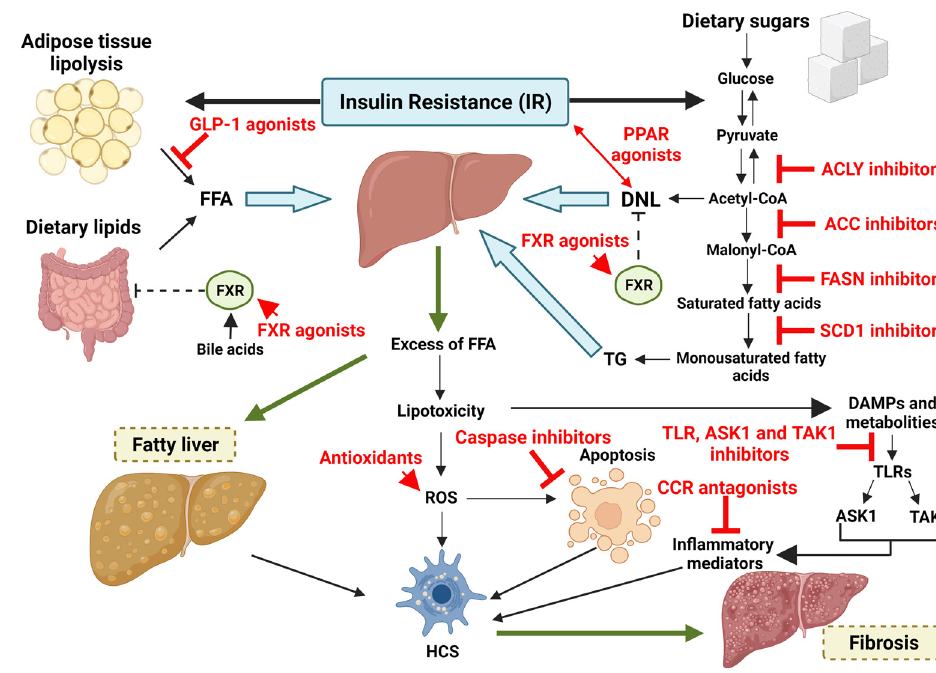
Figure 4. Possible therapeutic targets for the treatment of MAFLD and its subsequent fibrosis. Researchers are faced with trying to reduce the afflux of FA derived from adipose tissue lipolysis. In that direction, a potential role could be played by the glucagon-like peptide-1 (GLP-1) analog. GLP-1 is a peptide hormone produced and excreted by intesti- nal L cells, promoting insulin secretion and improving glucose homeostasis. Moreover, it reduces the liver non-esterified fatty acid (NEFA) overload caused by triglyceride decom- position. Beyond its metabolic effects, GLP-1 can delay gastric emptying and limit body weight increase, as well as it can inhibit inflammation and cell apoptosis [196]. For these reasons, GLP-1 receptor agonists have been proposed for the treatment of MAFLD. Lirag- lutide is the best-studied among all GLP1 agonists. In a phase 2 study (NCT01237119) on adult patients with NAFLD treated with Liraglutide, besides a reduction in body weight, a histological improvement with a reduction of the fibrosis index was shown [197]. Nev- ertheless, exenatide, another GLP-1 receptor agonist, proved to have a greater efficacy in improving the fibrosis stage than liraglutide [198]. Starting from this evidence, many stud- ies have been initiated using different molecules belonging to this pharmacological class (e.g., Semaglutinde, Cotadutide, and Tirzepatide) [199–201]. However, none of them are yet recommended to treat patients with NAFLD/MAFLD. Moreover, taking into account that a part of the circulating fats derives from foods ingested, efforts have been made to identify druggable pathways. For this purpose, a pos- sible therapeutical use of Fanitol X Receptor (FXR) agonists has emerged. FXR is a nuclear receptor expressed in the liver and small intestinal mucosa. It mediates a negative regula- tion on intestinal lipid absorption using bile acids as signals of excess circulating fats. Par- ticularly, FXR activation brings a downregulation of the expression of key lipogenic genes in the liver and reduces the hepatic lipid levels blocking DNL and promoting fatty acid oxidation [202]. In addition, it reduces the rate of IR in muscle and adipose tissue. To- gether, these effects conduct a reduction of lipotoxic lipids that, if in excess, can lead to a cascade of events ending in hepatic fibrosis [203]. The idea to use FXR agonists to treat patients with NAFLD derives from rodent models in which it has been proven that the deletion of FXR in the liver is followed by the appearance of liver steatosis, inflammation, and fibrosis [204]. Obeticholic acid (OCA) is the first FXR agonist that synthetizes as a competitive ligand of FXR. In fact, it binds to the receptor with 100-fold more potent